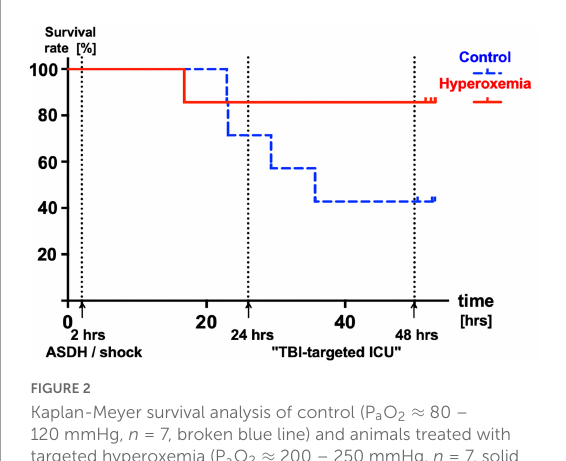
FIGURE2 Kaplan-Meyer survival analysis of control (P a O 2 ≈ 80 – 120 mmHg, n = 7, broken blue line) and animals treated with targeted hyperoxemia (P a O 2 ≈ 200 – 250 mmHg, n = 7, solid red line) during the first 24 h of resuscitation. Median (interquartile range) survival times 54 (54; 54) and 36 (26; 54) hours in the hyperoxemia and control groups, respectively ( p =